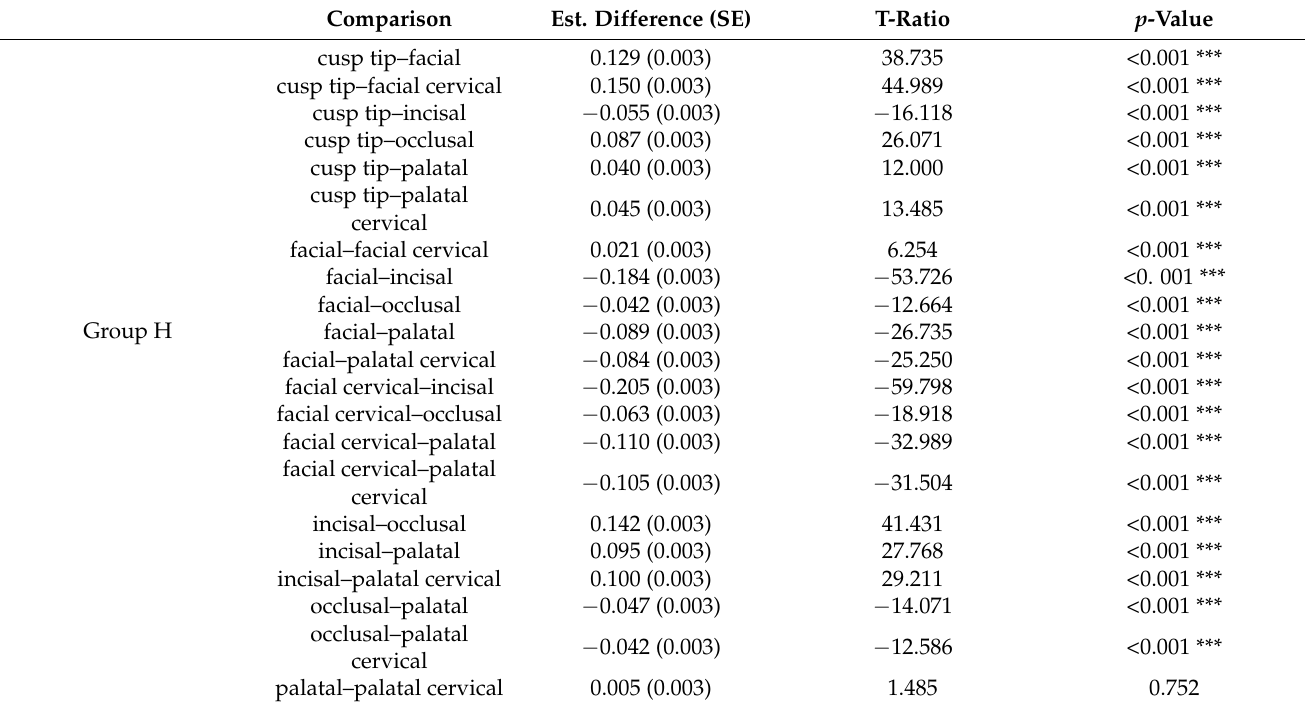
Figure 5. Boxplot showing the local thickness values at reference points for group high (H) and narrow (N). The local thickness values were aggregated by tooth measurement location. Highest values were seen at cusp tips, and palatal as well as palatal cervical faces. Table 5. Within-group comparison of local thickness values (mm) for group high (H) and narrow (N) aggregated for measurement location. Comparison was achieved using multiple comparison post hoc test with Tukey-method for p -value adjustment (family of 7 estimates), respectively. * p < 0.05, *** p <